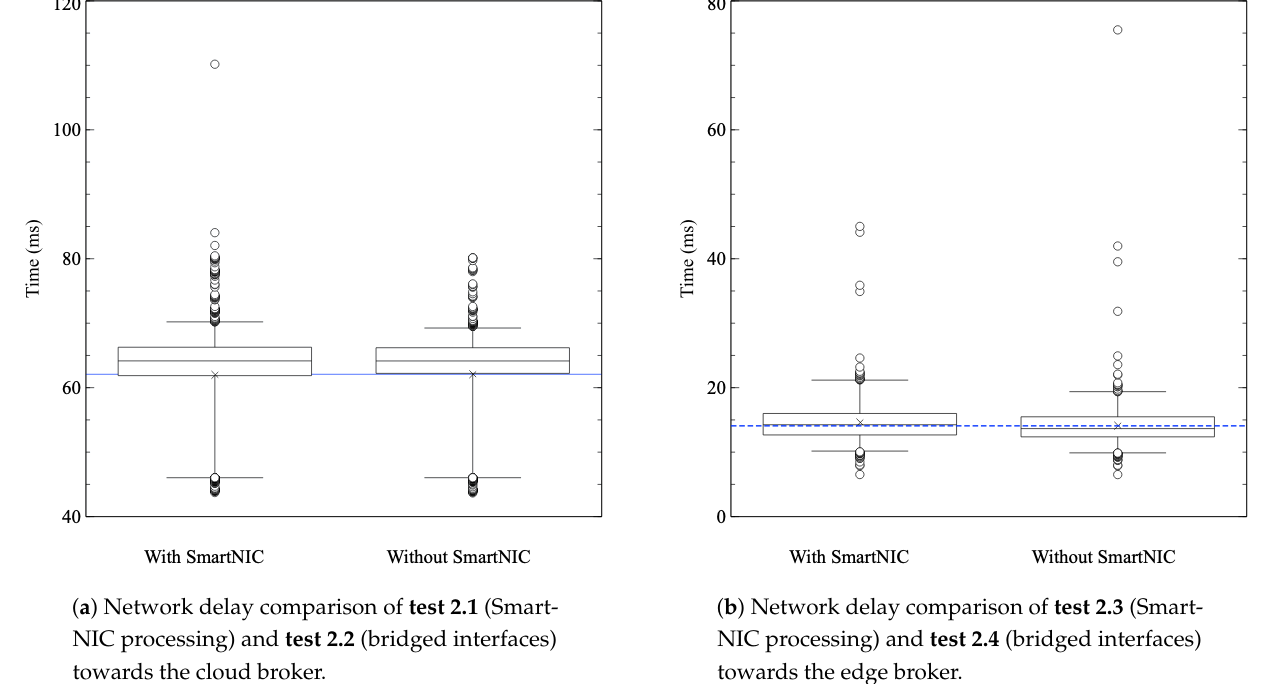
Figure 11. Network delay with and without SmartNIC processing. ( a ) Communications with the cloud broker. ( b ) Commu- nications with the edge